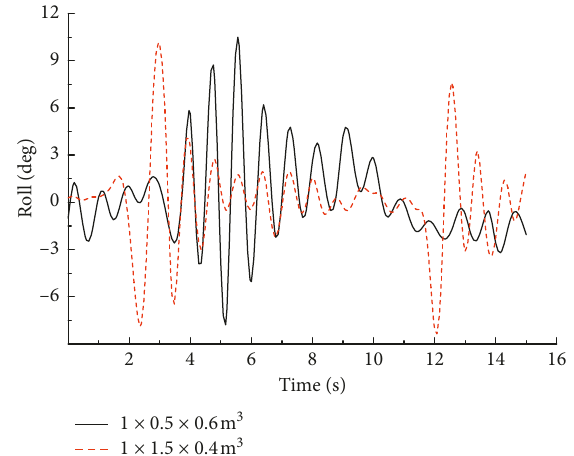
Figure 16: Time history curve of the rolling motion of the ship with different numbers of landslides. The labels are length, width, and thickness in sequence, such as the length is 1m, the width is 0.5m, and the thickness is